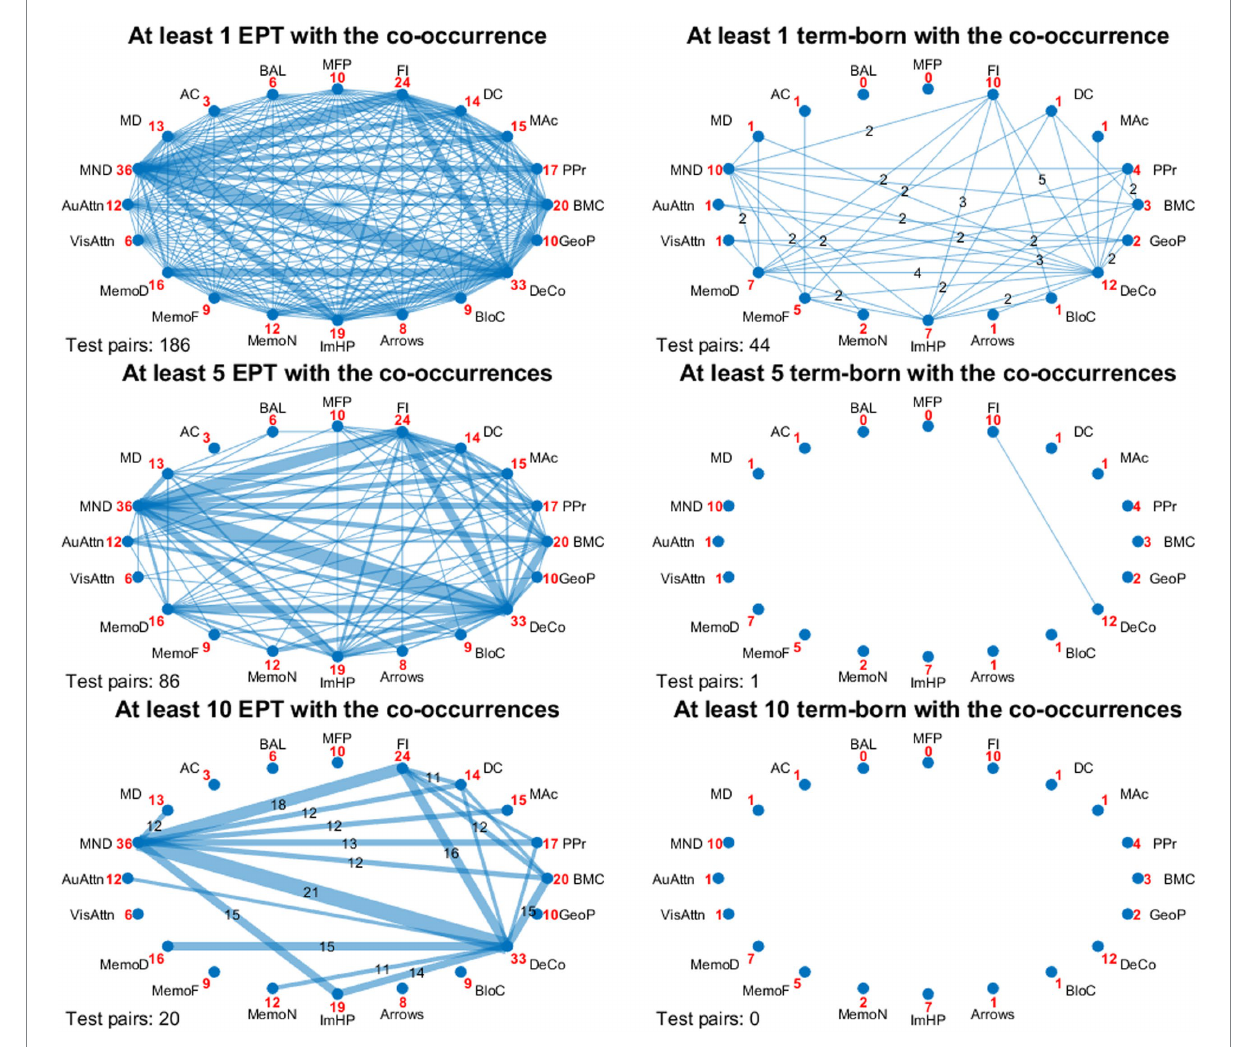
FIGURE 3 Relationship maps of 56 extremely preterm (EPT) and 37 term-born children who scored over 1SD below test norms concurrently in two test domains (test pairs). Relationships are presented with different cut-offs of 1, 5, and 10 children with co-occurrences. The number (in red) between a test abbreviation and a node indicates the number of children who gave an impaired score in that test domain. The number (in black, when present) above a connecting line indicates children with co-occurring impaired scores in the two line-connected test domains. The number bottom left of each map indicates the total number of impaired test pairs. Test abbreviations are clockwise in the upper semi-circle and anti- clockwise in the lower semi-circle: Upper semi-circle: Touwen Examination of Minor Neurological Dysfunction : MND, Movement Assessment for Children-second edition : MD, manual dexterity; AC, aiming and catching; BAL, balance. Sensory Integration and Praxis Test : MFP, manual form perception; FI, finger identification; DC, design copying; MAc, motor accuracy; PPr, postural praxis; BMC, bilateral motor coordination.